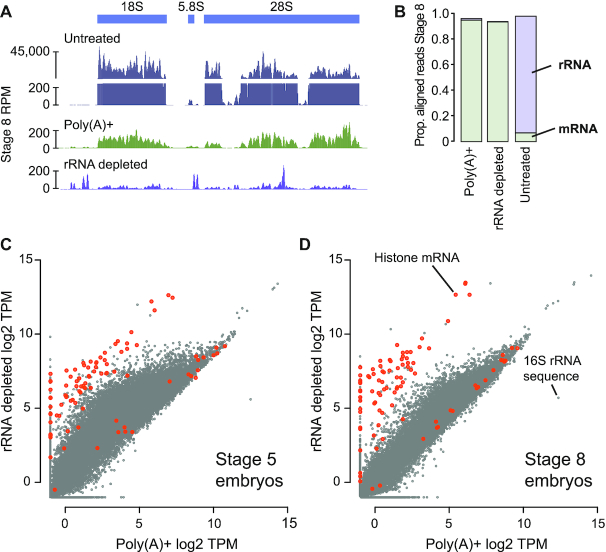
(A) Genome browser tracks comparing read coverage at the X. laevis 40S rDNA locus in untreated total RNA, poly(A)+ and rRNA depleted RNA-seq libraries from stage 8 embryos. Y-axis is discontinuous for the total RNA sample. (B) Stacked barplots showing proportion of aligned reads deriving from mRNA or lncRNA (green) versus rRNA (purple) in untreated, poly(A)+ and rRNA depleted RNA-seq libraries. (C, D) Biplots comparing log2 TPM expression levels and poly(A)+ and rRNA-depleted libraries at stage 5 and 8, respectively. Histone genes are highlighted in orange. RPM = reads per million, TPM = transcripts per million.